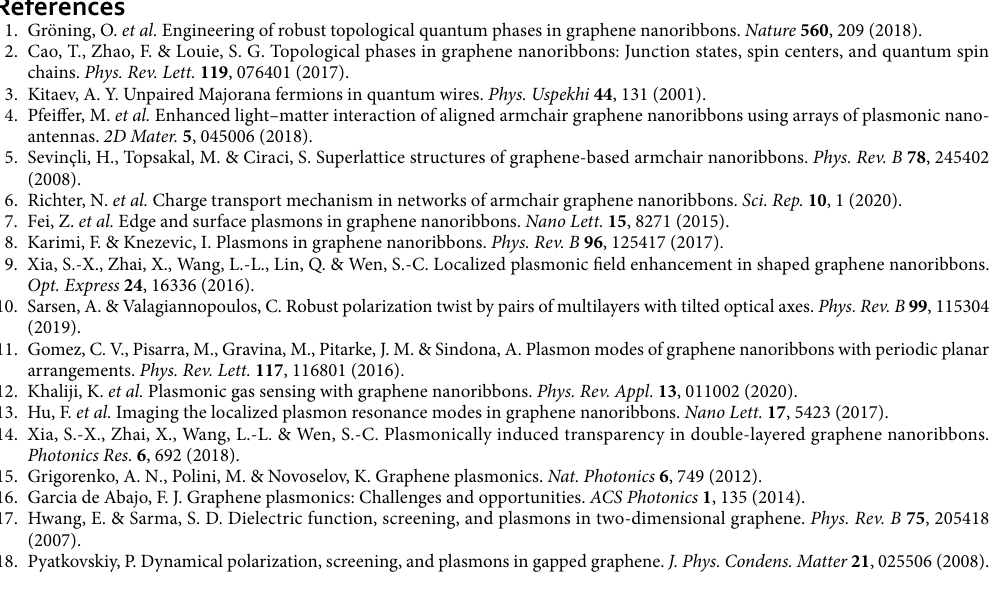
20 . Panel ( b ) displays plasmons for graphene (black) and a dice lattice = ( 0 ) 200 for E 1.0 . Inset ( i 1) in ( a ) illustrates all allowed transitions F / E = = T 3 ribbon, while inset ( i 2) in ( b ) exhibits single-particle excitation −